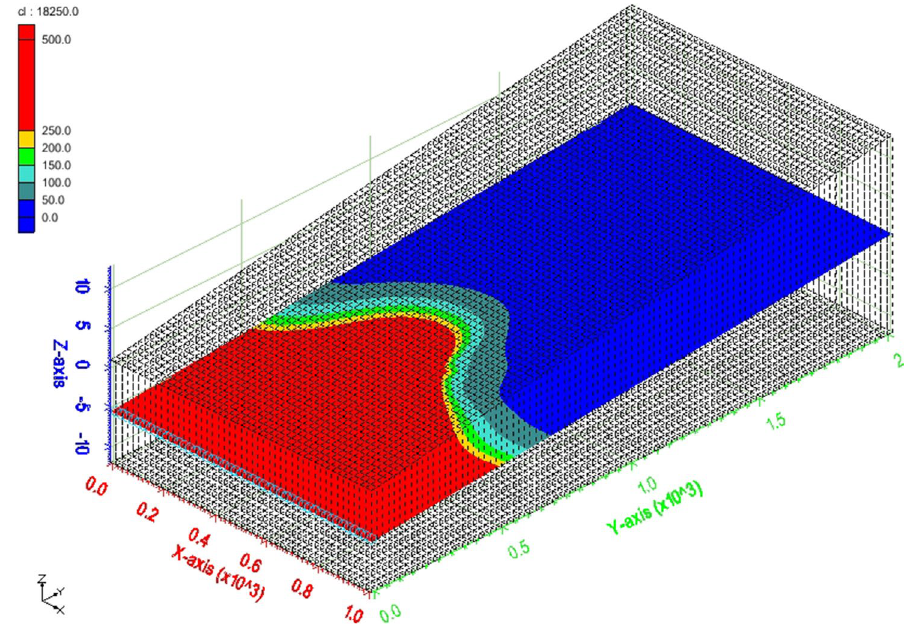
Fig. 2 Results of seawater